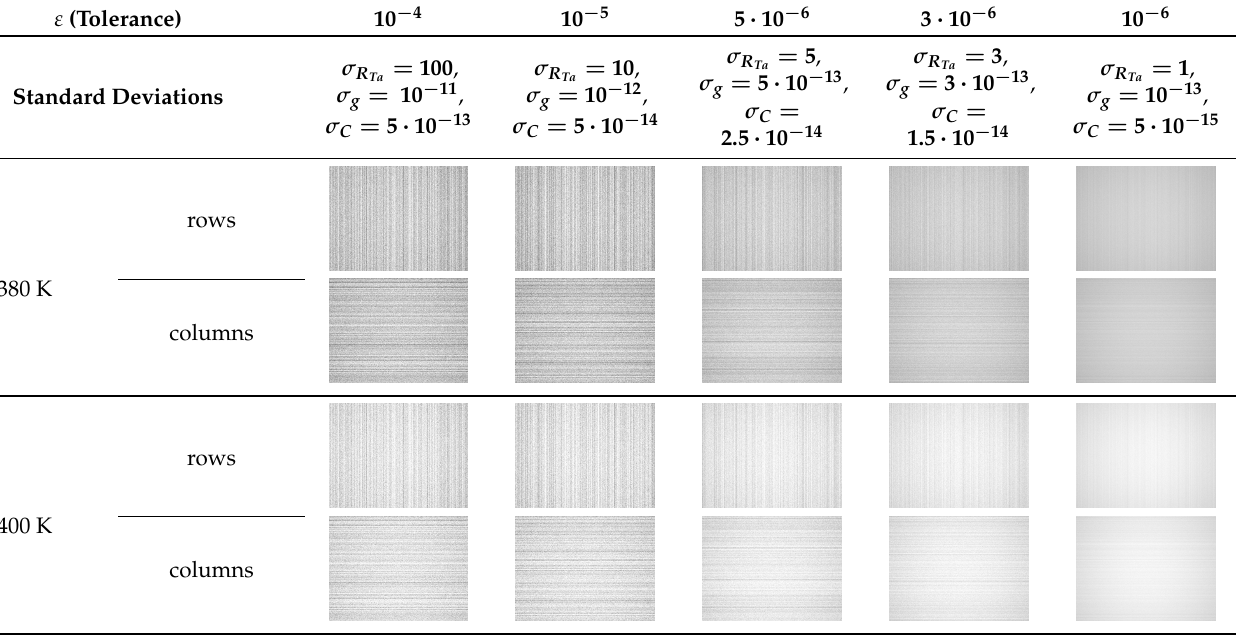
Table 2. Nonuniformity correction with varying fractional part widths of the correction coefficients. Simulation parameters: microbolometer resistance at ambient temperature R Ta = 123 [ Ω ] ,